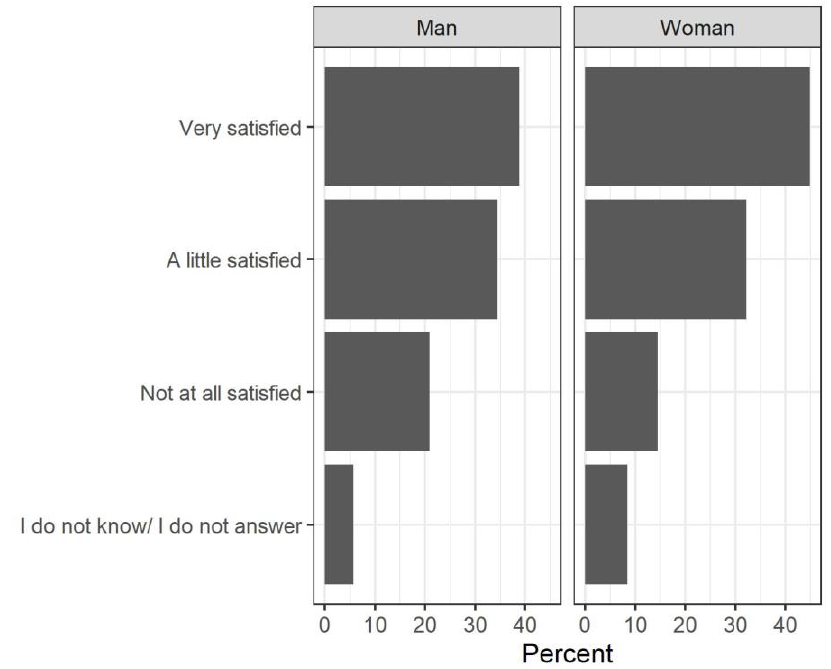
Figure A8. Cross-tabulation of attitudes of believers about the reopening of the Churches by gender (% by gender). X 2 = 16.03, df = NA, p = 0.029 (Pearson’s Chi-squared test with Scheme 2000. replicates).